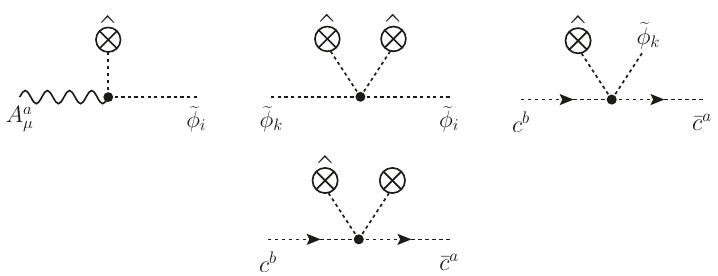
Figure 2 . The three ˆ v -insertion vertices on the first line correspond to the ˆ v -dependent two- and three-point vertices associated with the gauge-fixing term ∆ L fix (ˆ v, H ) , defined in (4.59). The double v ˆ v -insertion vertex on the second line contributes to the v expansion of the SB theory (4.57). Like for the case of the ˜ v insertions introduced in section 3.4, the (pseudo) external lines associated with ˆ v insertions do not involve any propagator and do not correspond to any field. Such external lines should be regarded as a technical tool to keep track of the total power in ˆ v induced by vertices stemming from ∆ L fix (ˆ v, H )